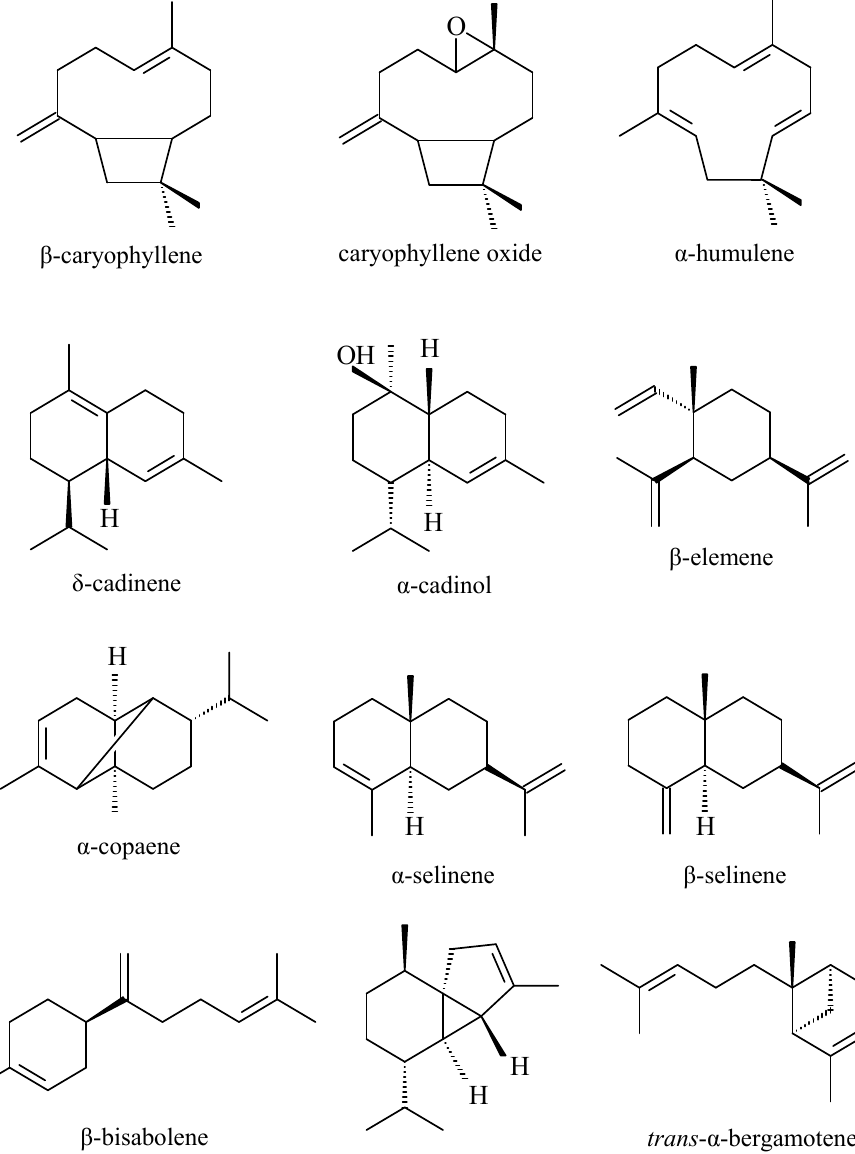
Figure 1. Main sesquiterpenes detected in copaiba